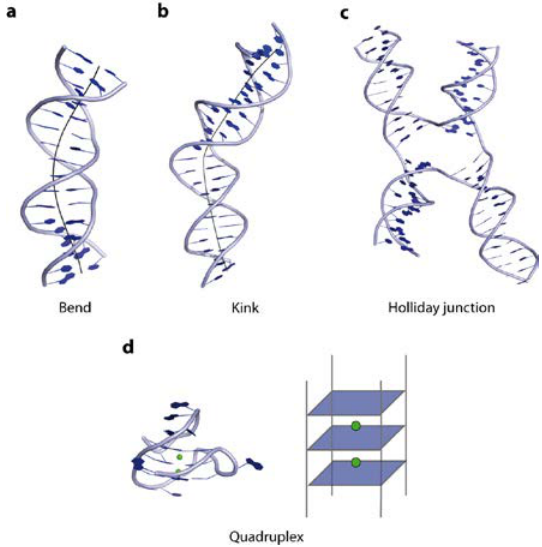
Figure 4. Illustration of DNA tertiary structures. ( a ) Curvature of the double helix